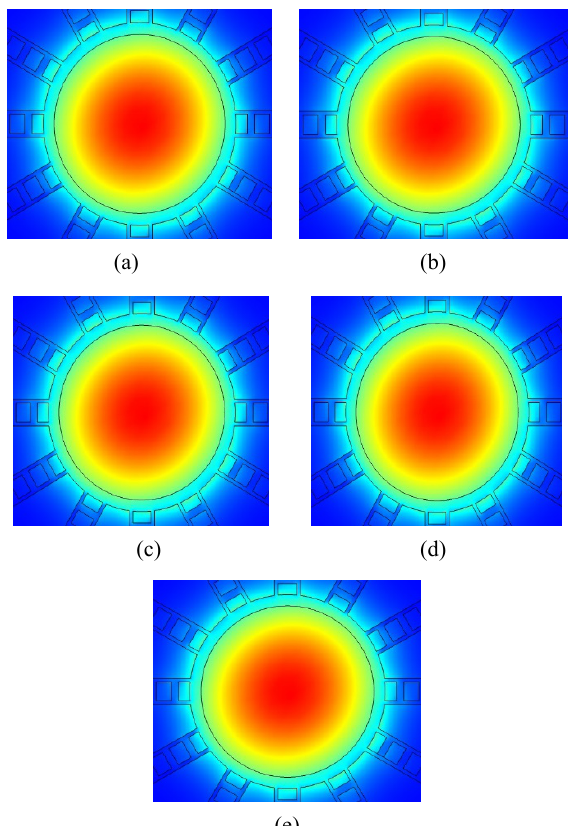
Fig. 14 Distribution of the electric field for different brain tissue samples at 2.2 THz: (a) NPS, n eff =1.310 8; (b) TB1, n eff =1.312 5; (c) TB2, n eff =1.314 3; (d) TB3, n eff =1.315 2; (e) TB4, n eff =1.317